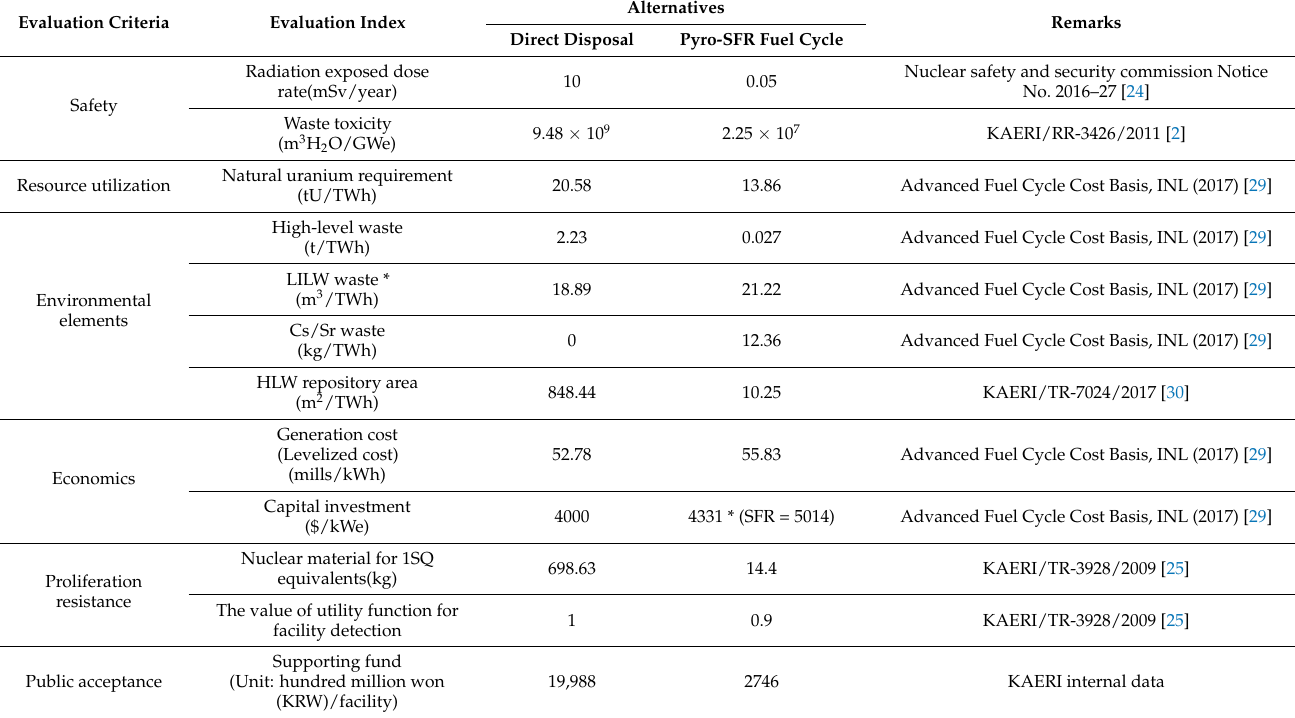
Table 7. Input data of multi-criteria decision-making